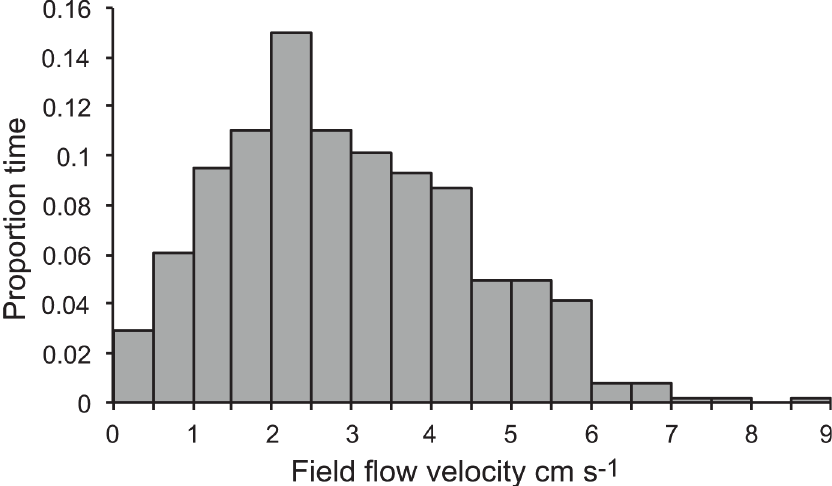
Fig 3. Field measurements. Proportional distribution of field flow velocities measured at 1 m depth outside the floating dock where wooden panels were deployed. Velocities were recorded every hour during 3 weeks using an acoustic doppler current profiler